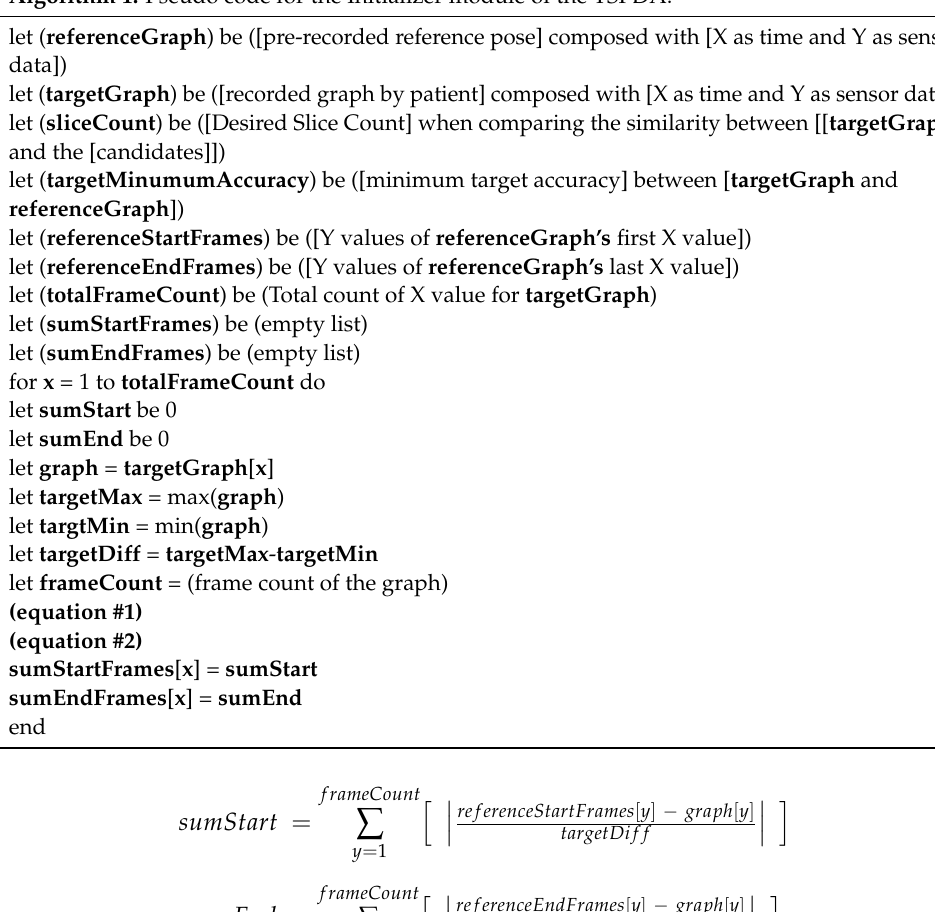
Algorithm 1: Pseudo code for the Initializer module of the